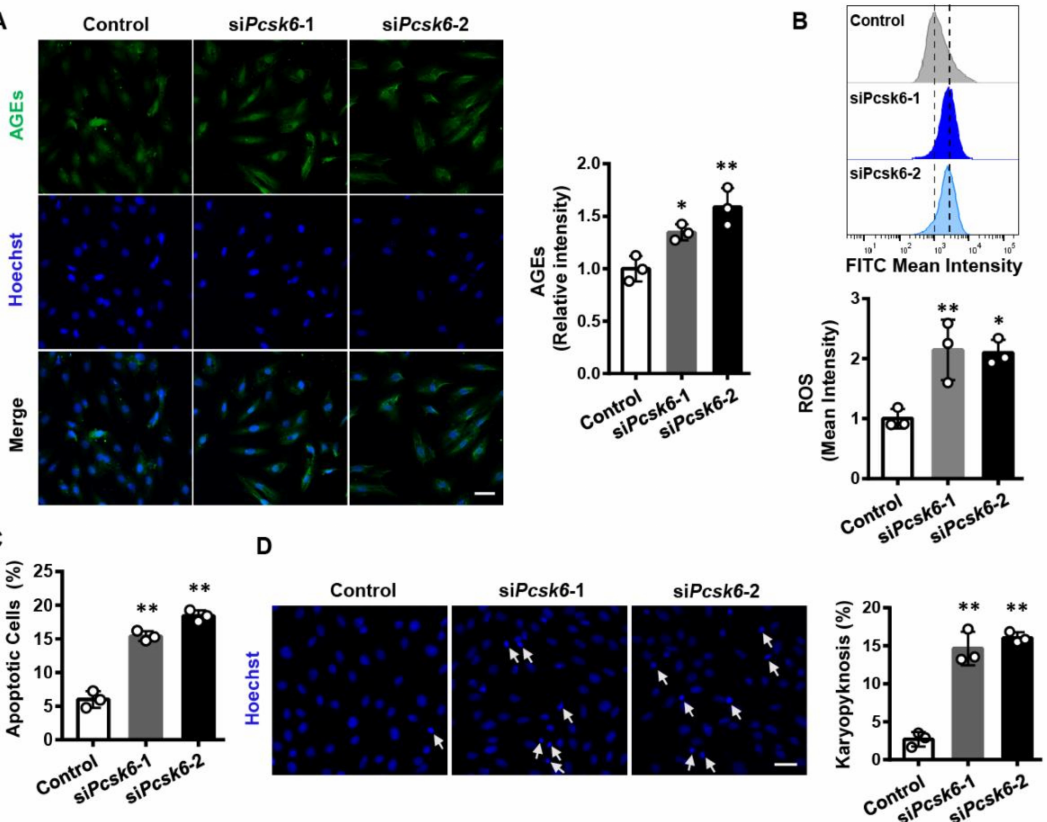
Figure 4. Impaired cardiomyocyte function by Pcsk6 knockdown. ( A ) Immunofluorescent staining for AGEs (green) and nuclei (blue) in si Pcsk6 -transfected H9c2 cells. Scale bar: 40 µ m. Analysis of quantitative data was conducted based on mean fluorescence intensity. ( B ) ROS production from si Pcsk6 -transfected H9c2 cells by flow cytometry with the FITC channel. ( C ) Apoptosis in si Pcsk6- transfected H9c2 cells detected by Annexin V-FITC in flow cytometry. ( D ) Hoechst 33342 staining for apoptosis in si Pcsk6 -transfected H9c2 cells. Scale bar: 40 µ m. Arrows indicate karyopyknosis. Data are means ± S.D. * p < 0.05, ** p < 0.01 vs.